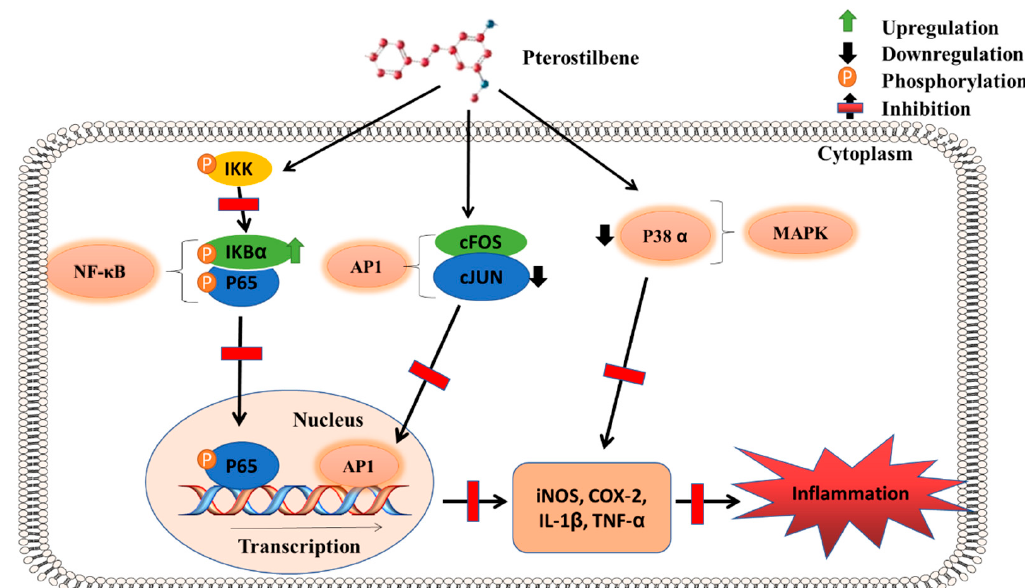
Figure 3. Anti-inflammatory pathway of pterostilbene : PTS mediates its anti-inflammatory effect mainly through the inhibition of the transcription factors NF κ B and AP-1, which leads to the attenuation of downstream pro-inflammatory mediators, including TNF- α . Further, PTS also inhibits P38 mitogen-activated protein kinase (MAPK) signaling and prevents the induction of iNOS and COX- 2.